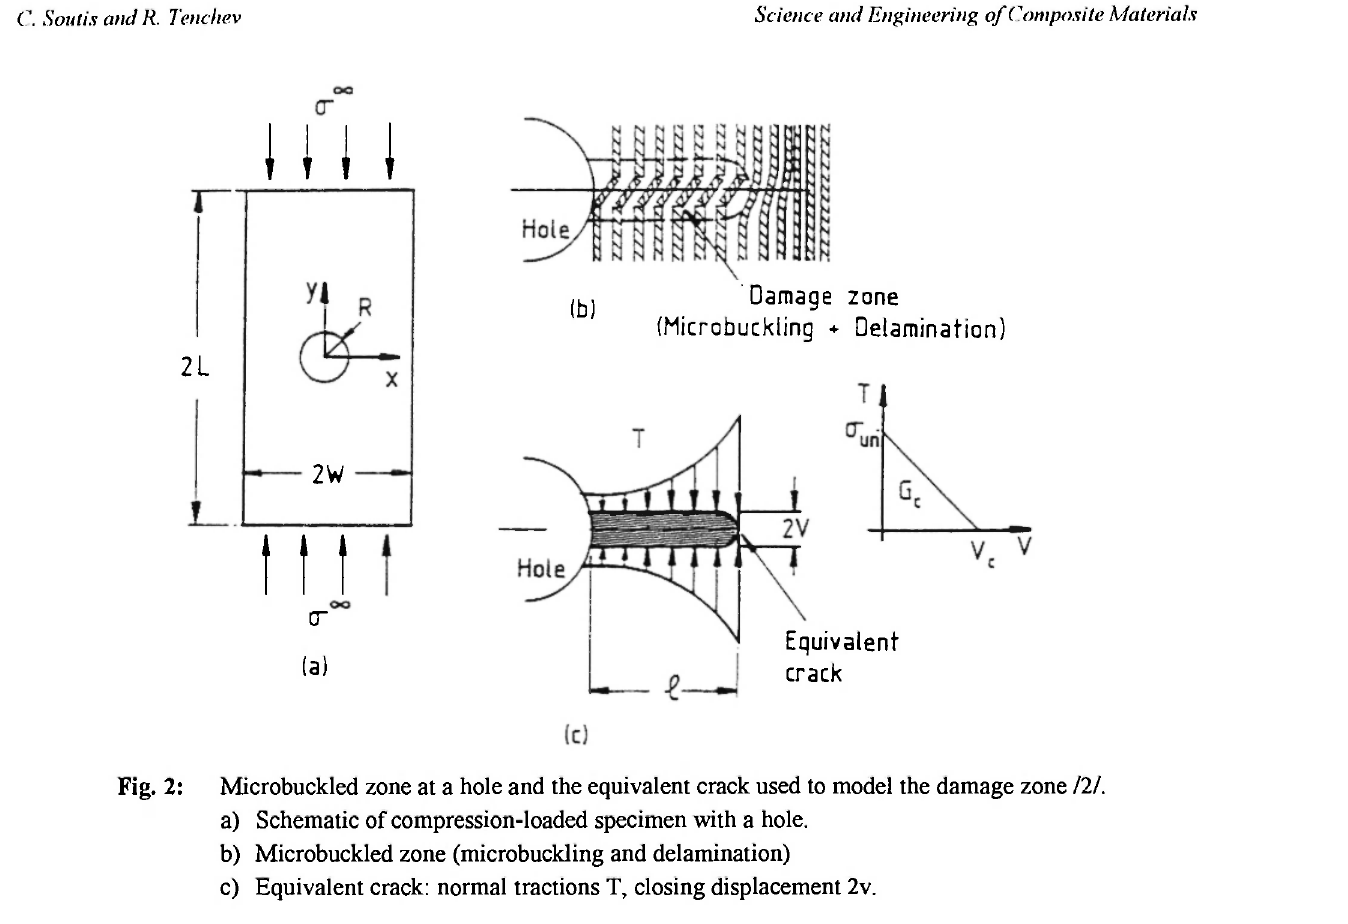
Fig. 2: Microbuckled zone at a hole and the equivalent crack used to model the damage zone 111. a) Schematic of compression-loaded specimen with a hole. b) Microbuckled zone (microbuckiing and delamination) c) Equivalent crack: normal tractions T, closing displacement